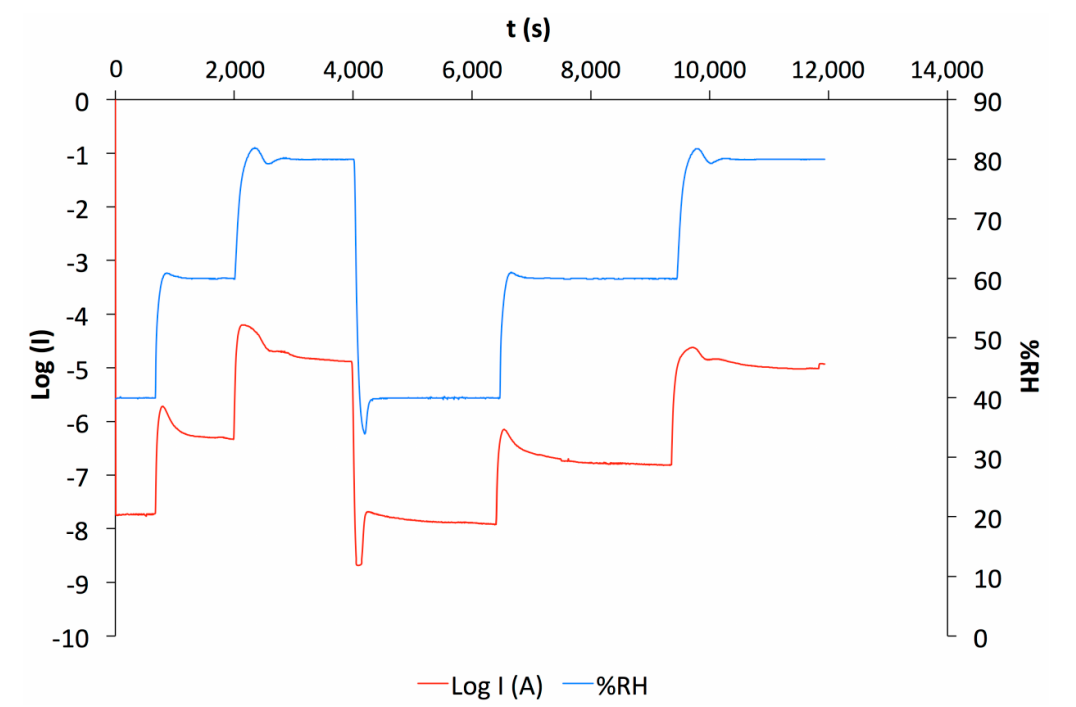
Figure 3. Humidity exposure experiment performed on s-CoPc/PEG sample